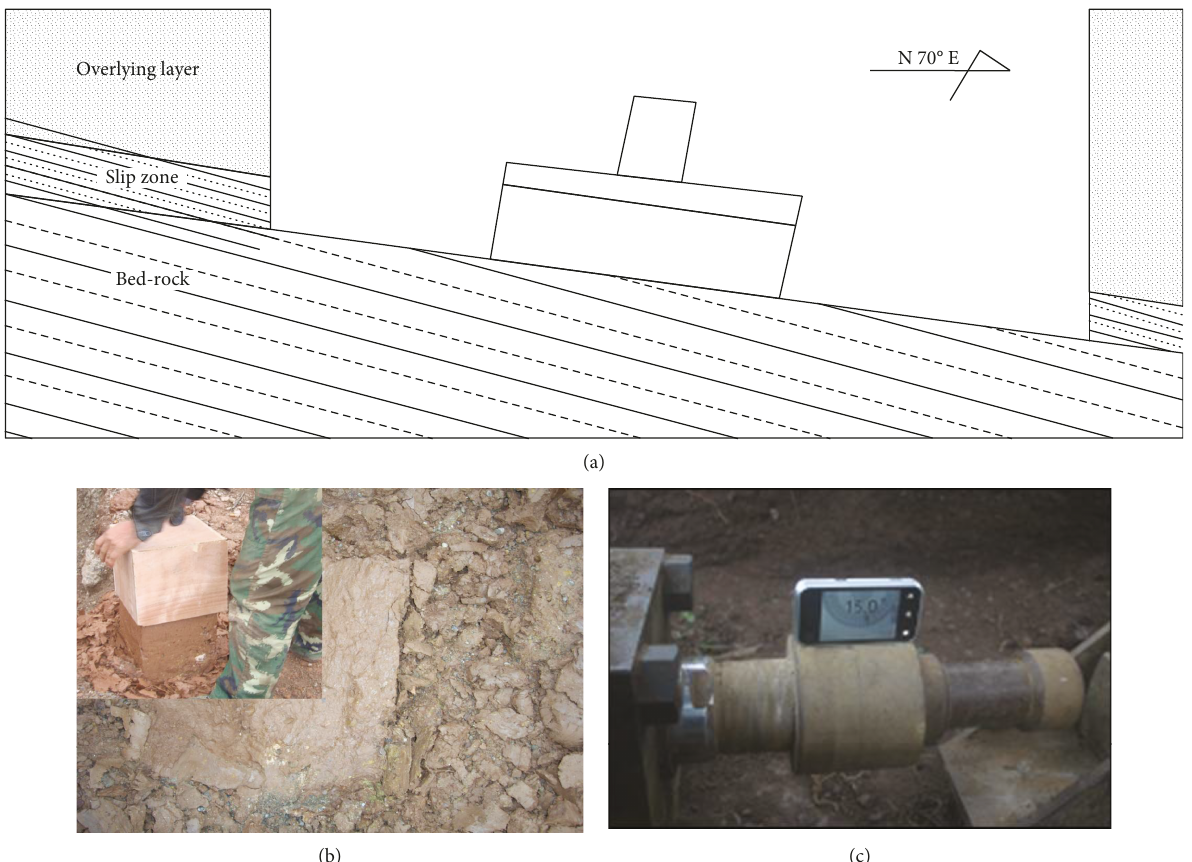
Figure 12: Sample preparation for test in fi eld. (a) Schematic diagram of pruning samples, (b) inclined pruning samples, and (c) inclined push shear.